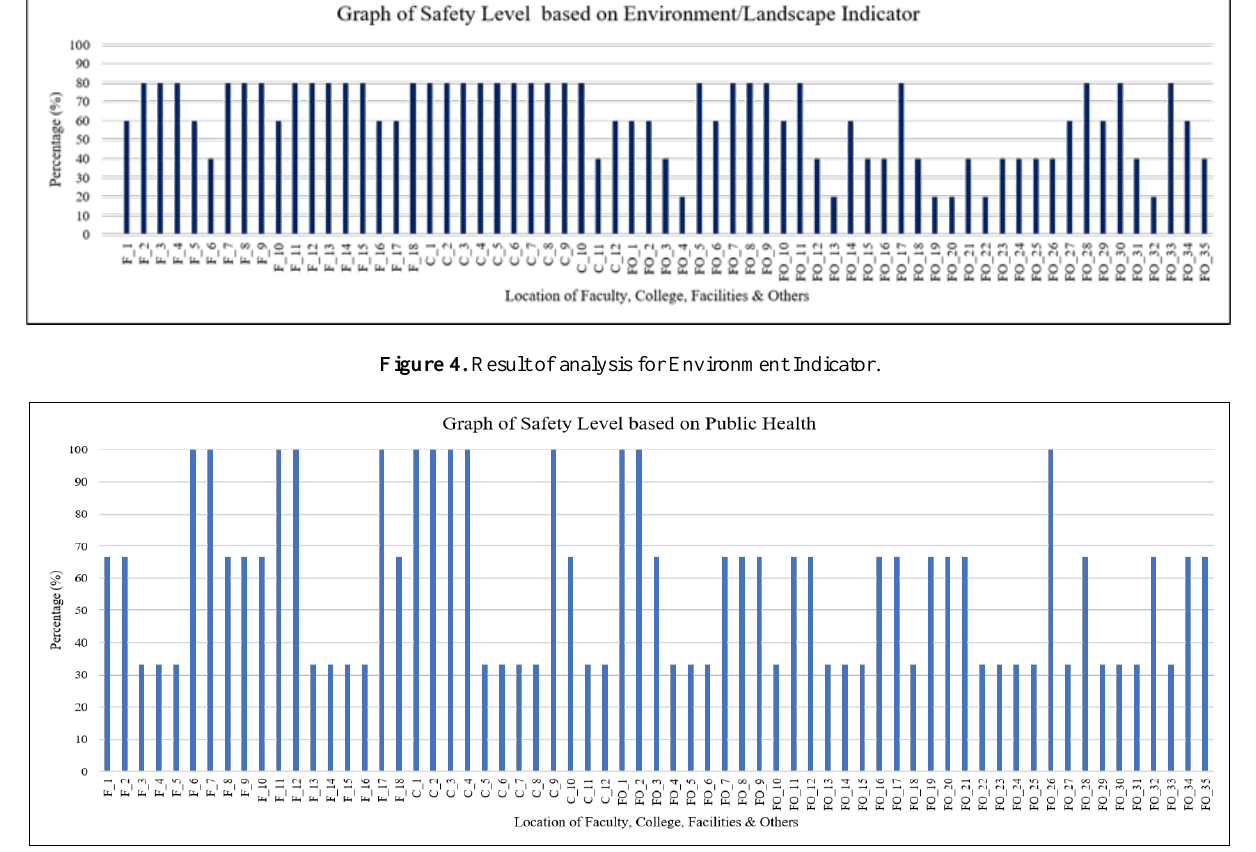
Figure 5 . Result of analysis for Public Health